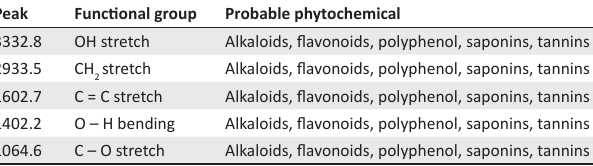
TABLE 3: Major peaks on Fourier transform infrared spectra of Harrisonia abyssinica ethanolic extracts.